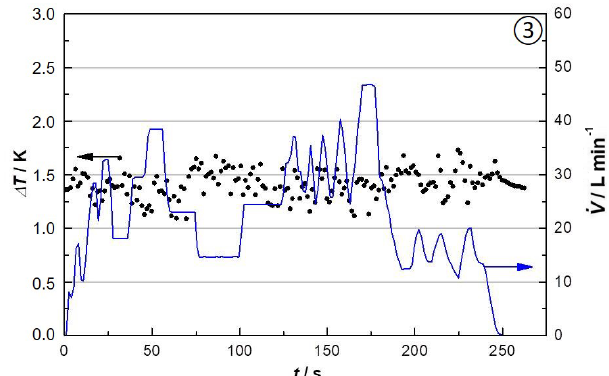
Figure 6. Measured sensor signal ( T abs = 300 ◦ C) over time for the best mounting configuration (position (3), 90 ◦ orientation) with dy- namically changing flow rates in the range from 0 to 48Lmin − 1